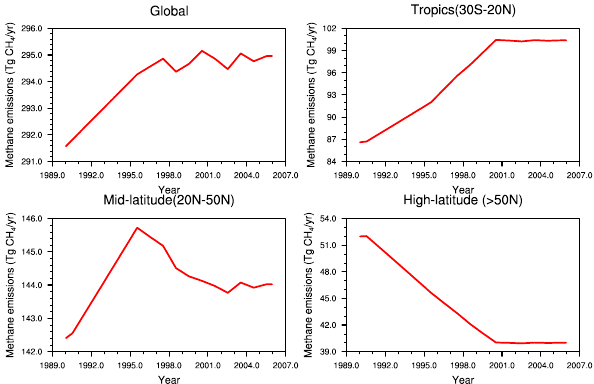
Figure 3. The interannual anthropogenic methane emissions over the globe, in the tropics, mid-latitudes, and high latitudes. These data sets are obtained from TransCom (Patra et al., 2010)